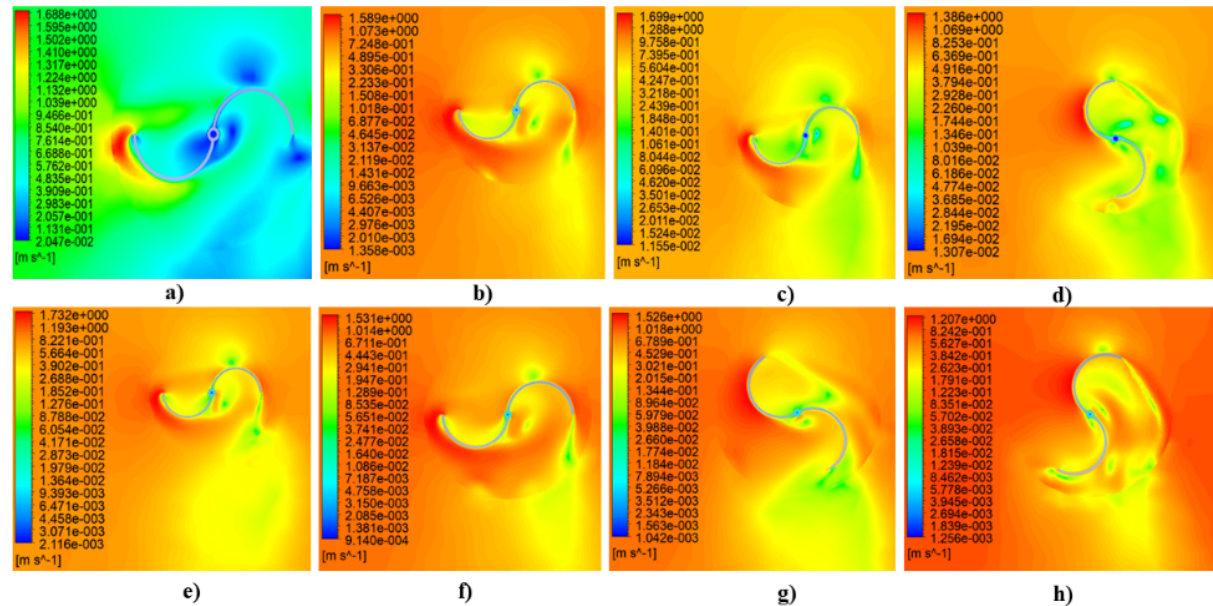
Figure 15: Distribution of velocity on a) Rotor Single Stage, b)Rotor Two-Stage 0 ∘ , c) First Stage Rotor Two-Stage 90 ∘ , d) Second Stage Rotor Two-Stage 90 ∘ , e) Rotor Three Stage 0 ∘ , f) First Stage Rotor Three Stage 120 ∘ , g) Second Stage Rotor Three Stage 120 ∘ , and h) Third Stage Rotor Three Stage 120 ∘ .